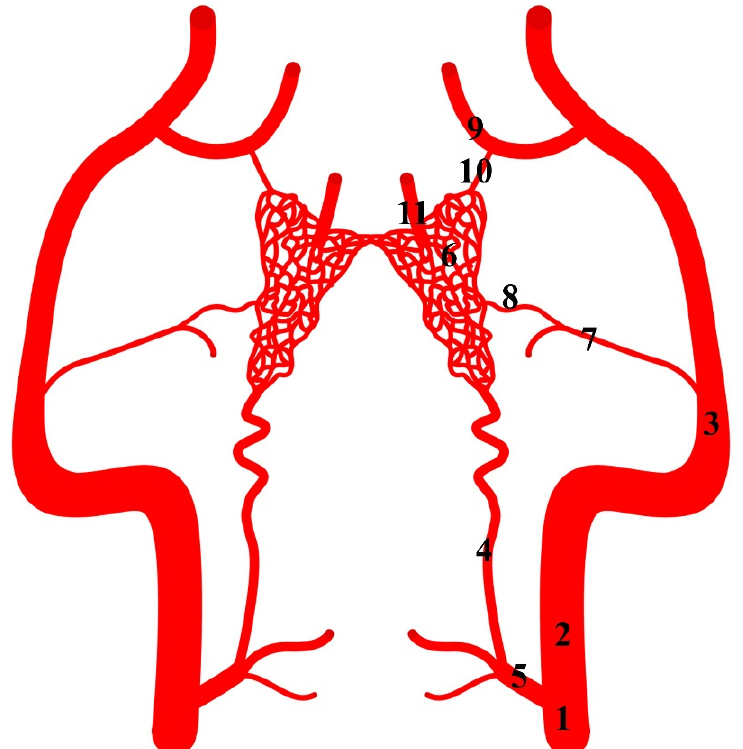
Figure 5. Diagram of the arterial pattern in the collared peccary ( Pecari tajacu ). 1—common